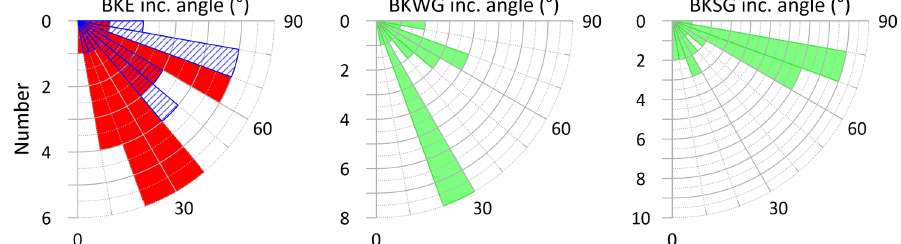
Figure 7. Distributions of the incidence angles of the polarization vector for the stations BKE, BKWG and BKSG. For BKE, the blue and red sectors are associated with the distribution of LFs and LPs,